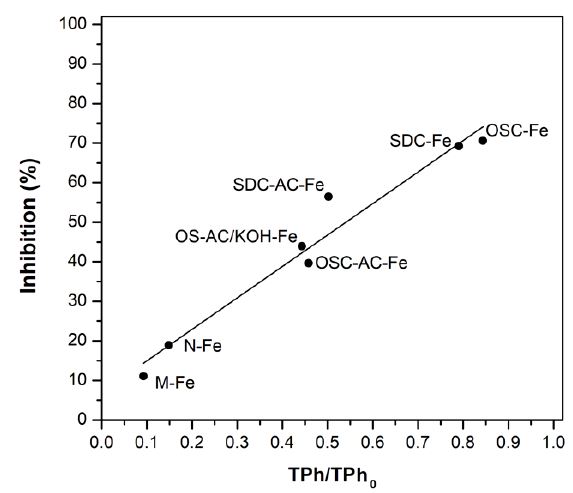
Figure 14. TPh/TPh 0 vs. inhibition (%) of the V. fischeri bacteria after 30 min of contact time with the different solutions after CWPO.